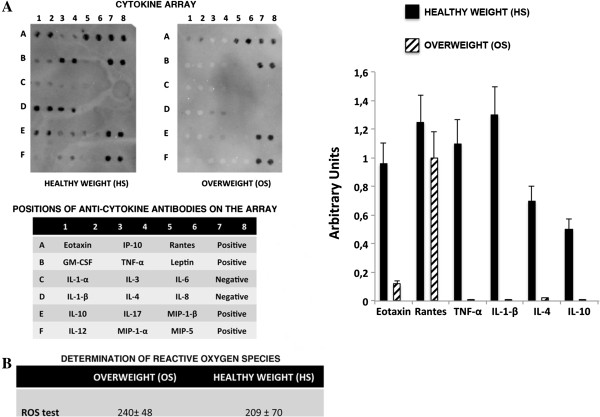
Cytokine and reactive oxygen species (ROS) detection in sera. A) Arrays incubated with HS and OS samples. The table below the arrays shows the name and the relative position on the Panomics TranSignal Human Cytokine Antibody Array of the cytokines that were detected in OS and HS sera. On the table ‘Positive’ and ‘Negative’ are the array internal controls. Array signals were acquired using the Chemidoc system (Bio-Rad) and the associated software QuantityOne. The graph shows the cytokine expression levels in the OS and HS sera. Data are expressed as arbitrary units (*P < 0.05). B) The table shows the expression of ROS in HS and OS samples. Data are expressed in arbitrary units (± SD, number of experiment replicates: three). HS, healthy weight sera; OS, overweight sera.